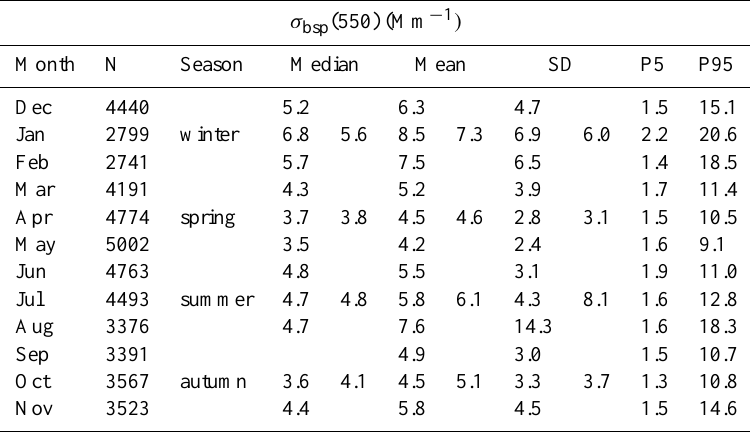
Table 5c. Basic statistical properties of σ bsp (550) organized for each month and season between 2002 and